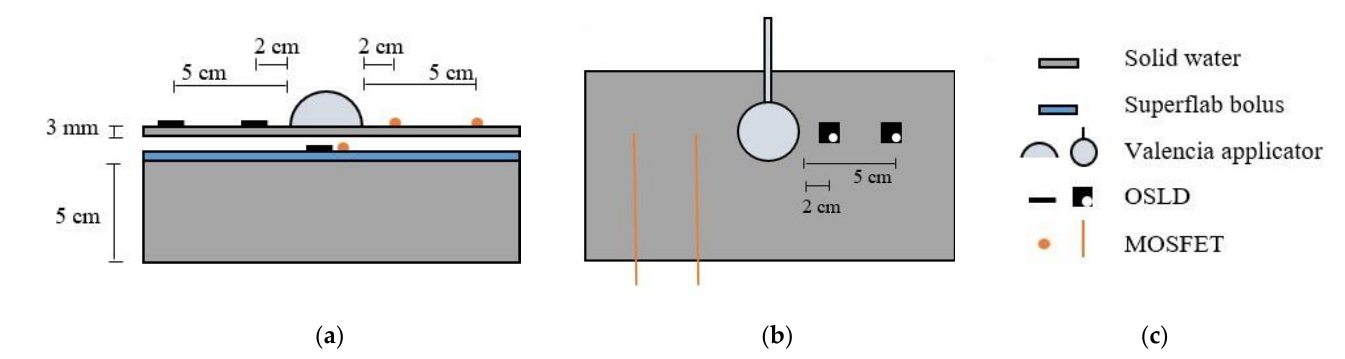
Figure 8. An interpretation of the phantom used to test OSLDs using an H3 Valencia applicator. ( a ) Side view of the phantom indicating the positions of the Valencia, OSLDs, and MOSFETs; ( b ) Top view of phantom indicating the symmetric position of the OSLDs with the MOSFETs about the head of the Valencia; ( c ) A legend describing the components of the phantom depicted in ( a ) and ( b ).